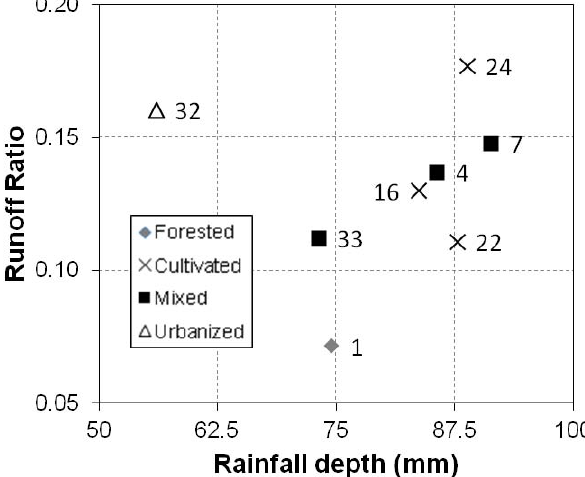
Fig. 14. Relationship between runoff ratio and rainfall depth for 8 IPEC catchments showing consistency between surveyed and sim- ulated peak